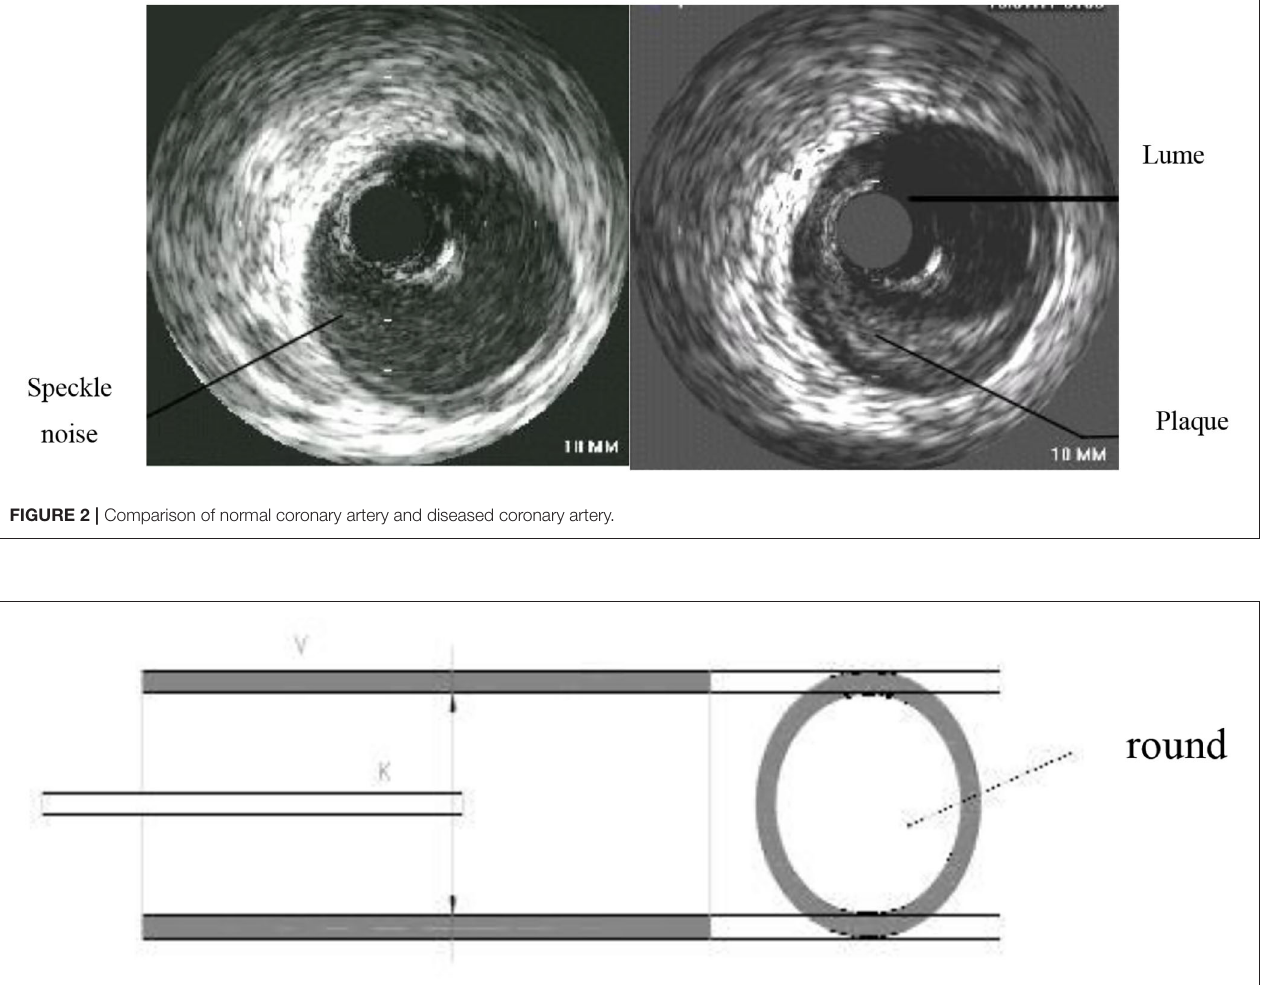
FIGURE 3 | The position of the ultrasound catheter in the center of the blood vessel.